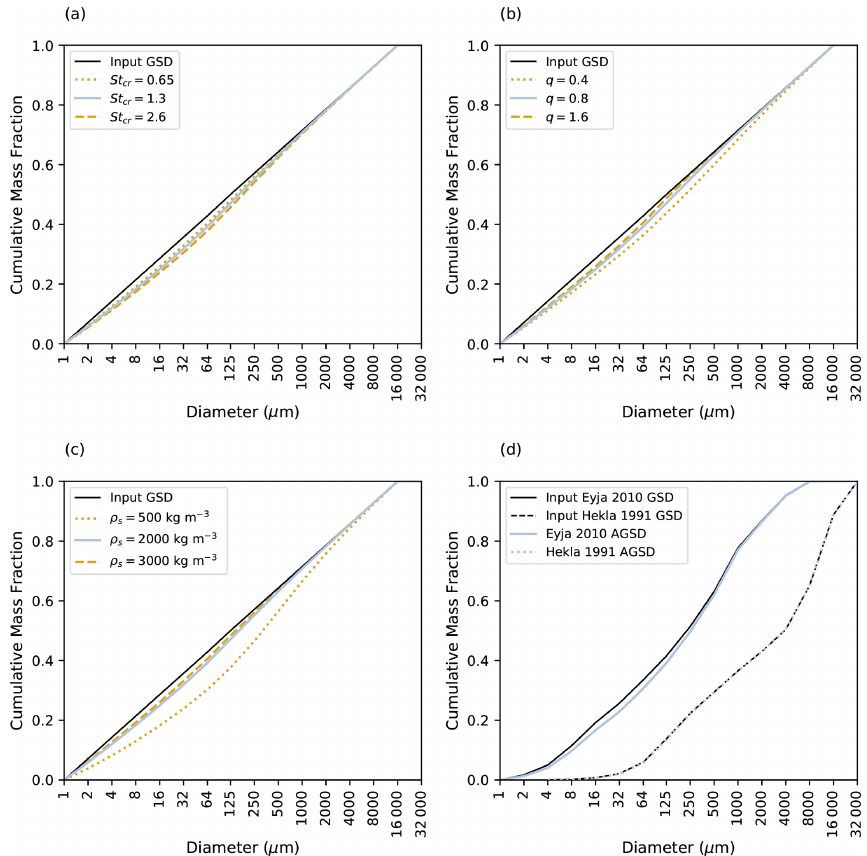
Figure 3. Sensitivity of the output aggregated GSD to the sticking efficiency parameters, (a) St cr and (b) q , and the physical characteristics assigned to the particles, (c) particle density ρ s , and (d) input GSD. Output is for 19:00UTC on 4 May 2010, and the plume height is 7000ma.s.l. (cf. Fig. 2a). Note that the blue lines represent simulations using the control values, and AGSD is the aggregated